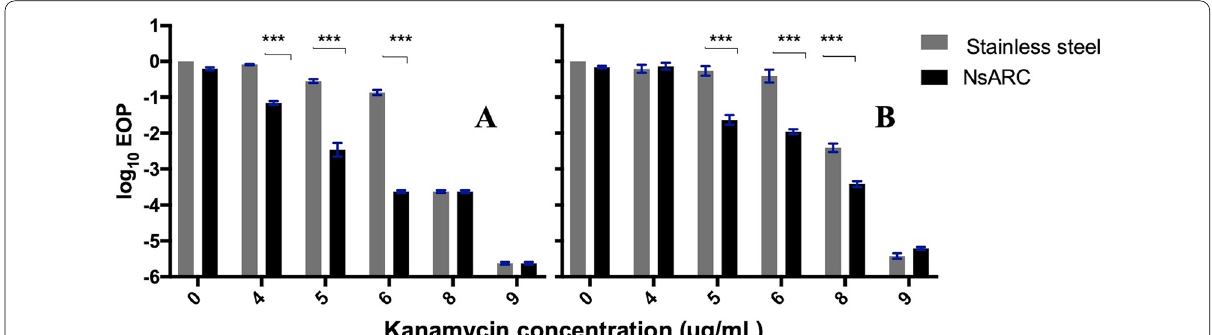
Fig. 1 Response of E. coli to various concentrations (µg/ml) of kanamycin after exposure to stainless steel and NsARC ( A ) under visible light ( B ) in the dark. Error bars are standard error of means (SEM). Asterisks indicate P values. *P < 0.05; **P < 0.01; ***P < 0.001; NS not significant